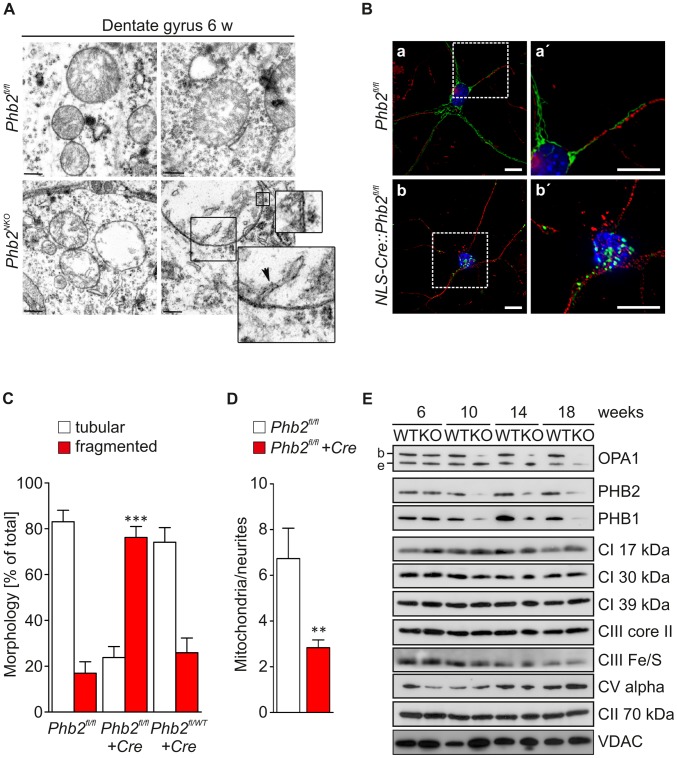
Defective mitochondrial morphogenesis and ultrastructure in Phb2-deficient neurons in vivo.(A) Transmission electron microscopy analysis of the mitochondrial ultrastructure in DG neurons of 6-week-old Phb2NKO and Phb2fl/fl control mice. The enlargements show the double membrane of the mitochondrion and the emergence of one crista. Scale bar: 400 nm. (B) Fragmentation and perinuclear clustering of PHB2-deficient neuronal mitochondria. Primary hippocampal neurons isolated from E18.5 Phb2fl/fl embryos were infected with lentiviruses expressing mitochondrially targeted EGFP and Cre recombinase (NLS-Cre) as indicated. Fixed samples were immunostained with antibodies directed against GFP and neuronal βIII-tubulin followed by DAPI staining. a′, b′ are magnifications of the boxed insets shown in a, b. Scale bars: 10 µm. (C) Quantification of mitochondrial morphology in PHB2-deficient and control primary hippocampal neurons. Cells were infected with lentiviruses expressing Cre recombinase when indicated and processed as described in (B). Cells containing tubular (white bars) or fragmented mitochondria (red bars) were classified. >200 cells were scored in three independent experiments. ***P<0.001. Error bars indicate SEM. (D) Quantification of mitochondria per neurites in PHB2-deficient primary hippocampal neurons. Phb2fl/fl neurons were infected with lentiviruses expressing Cre recombinase when indicated and processed as described in (B). >30 cells were scored in three independent experiments. **P<0.01. Error bars indicate SEM. (E) Immunoblot analysis of hippocampal tissue lysates from Phb2NKO (KO) and Phb2fl/fl (WT) control mice of the indicated age. Lysates were analyzed by SDS-PAGE and immunoblotting using the indicated antibodies. Antibodies directed against VDAC and the 70 kDa subunit of complex II were used to monitor equal gel loading. b/e: long/short OPA1 isoforms.